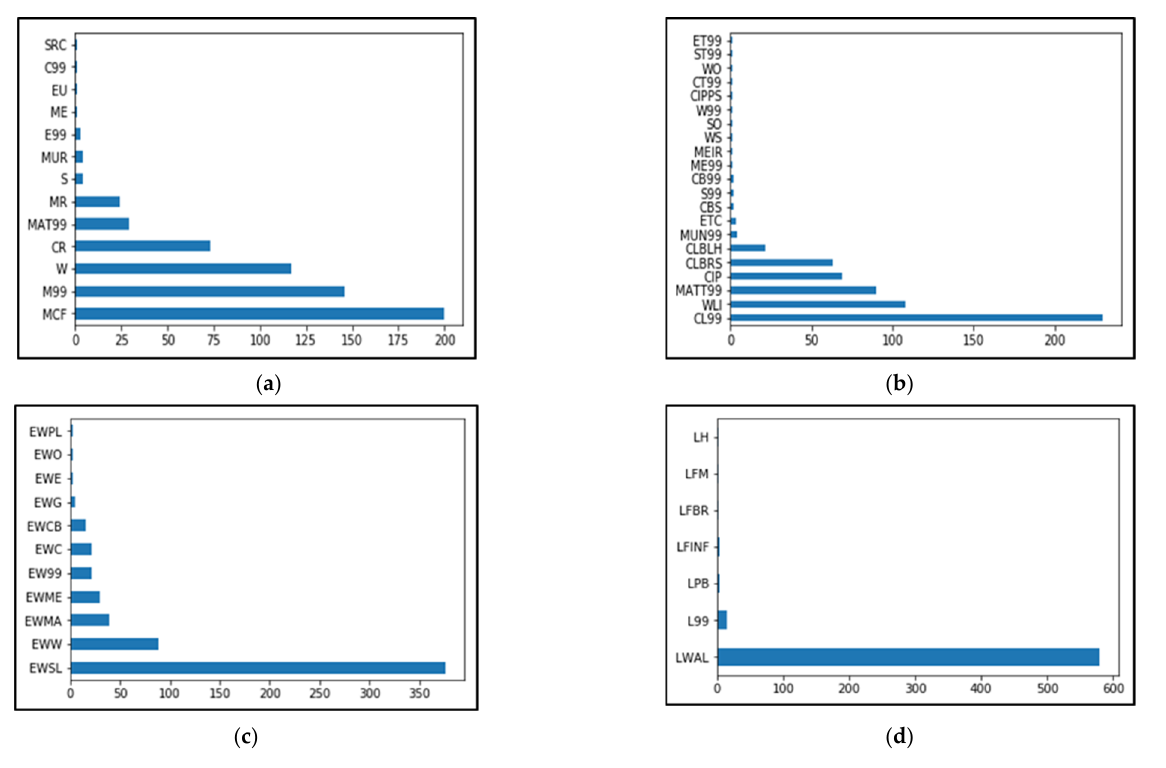
Figure A5. Distribution of attribute values within the GEM V.2.0 taxonomy for 604 inspected buildings in Valparaíso for ( a ) material type, ( b ) material technology, ( c ) non-structural exterior walls, and ( d ) lateral load-resisting system.